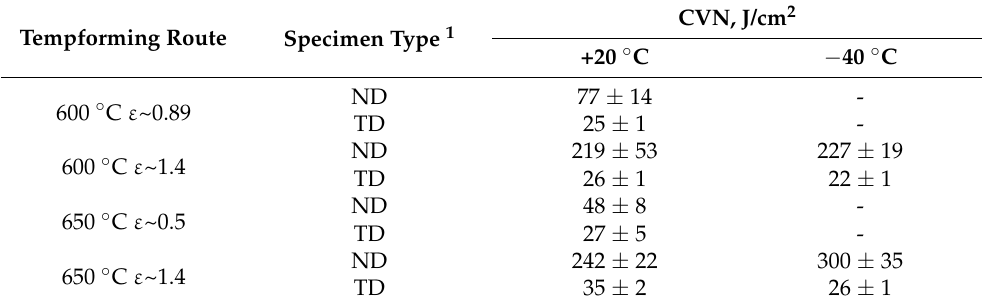
Figure 6. Load–deflection curves of tempformed (TF) steel: ( a , b ) TD-Charpy V-Notch specimen, ( c , d ) ND-Charpy V-Notch specimen. The line types for different rolling reductions ( ε ) and different test temperatures are indicated in inserts ( a ) for 600 ° C and ( b ) for 650 ° C. Table 6. Average absorbed impact energies and their standard deviations of Charpy V-Notch speci- mens in different directions of the tempformed